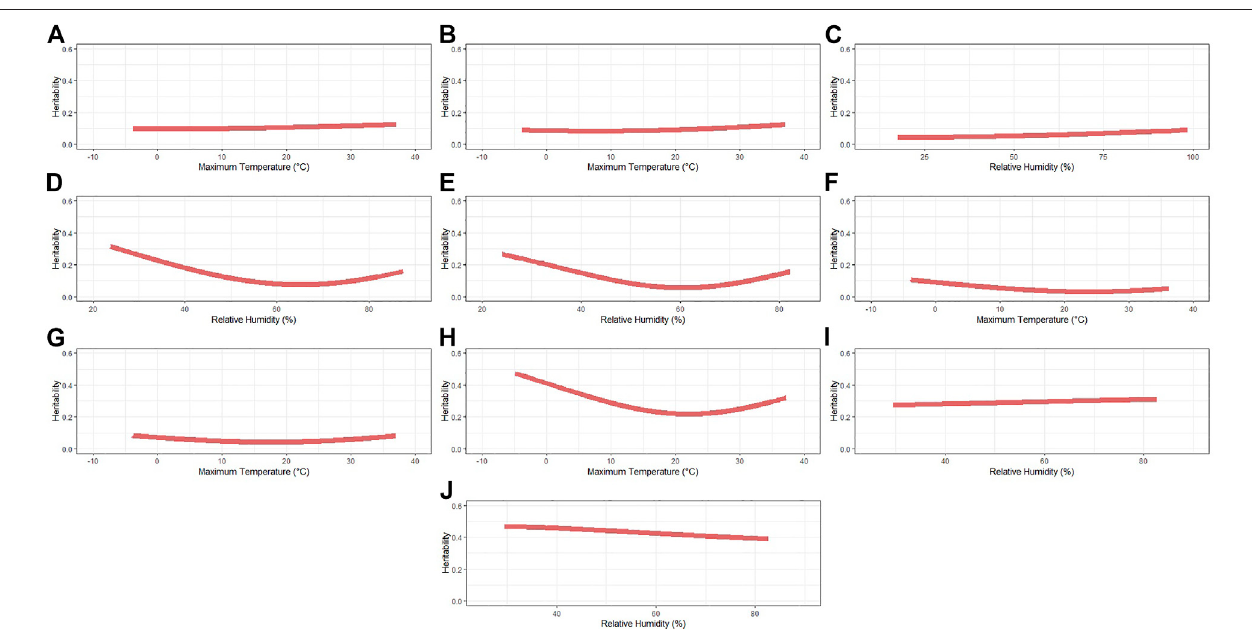
FIGURE 1 | Heritability estimates for each recommended environmental variable and critical period for each studied trait. (A) Total number of piglets born. (B) Number of piglets born alive. (C) Number of piglets born dead. (D) Number of piglets weaned considering measurement until weaning date. (E) Weaning weight (kg) considering the measurement of records until weaning date. (F) Interval between wean to estrus (days). (G) Interval between farrows (days). (H) Off-test weight (kg) considering an interval of 30 days. (I) Ultrasound muscle depth (mm) considering an interval of 30 days. (J) Ultrasound backfat thickness (mm) considering an interval of 30